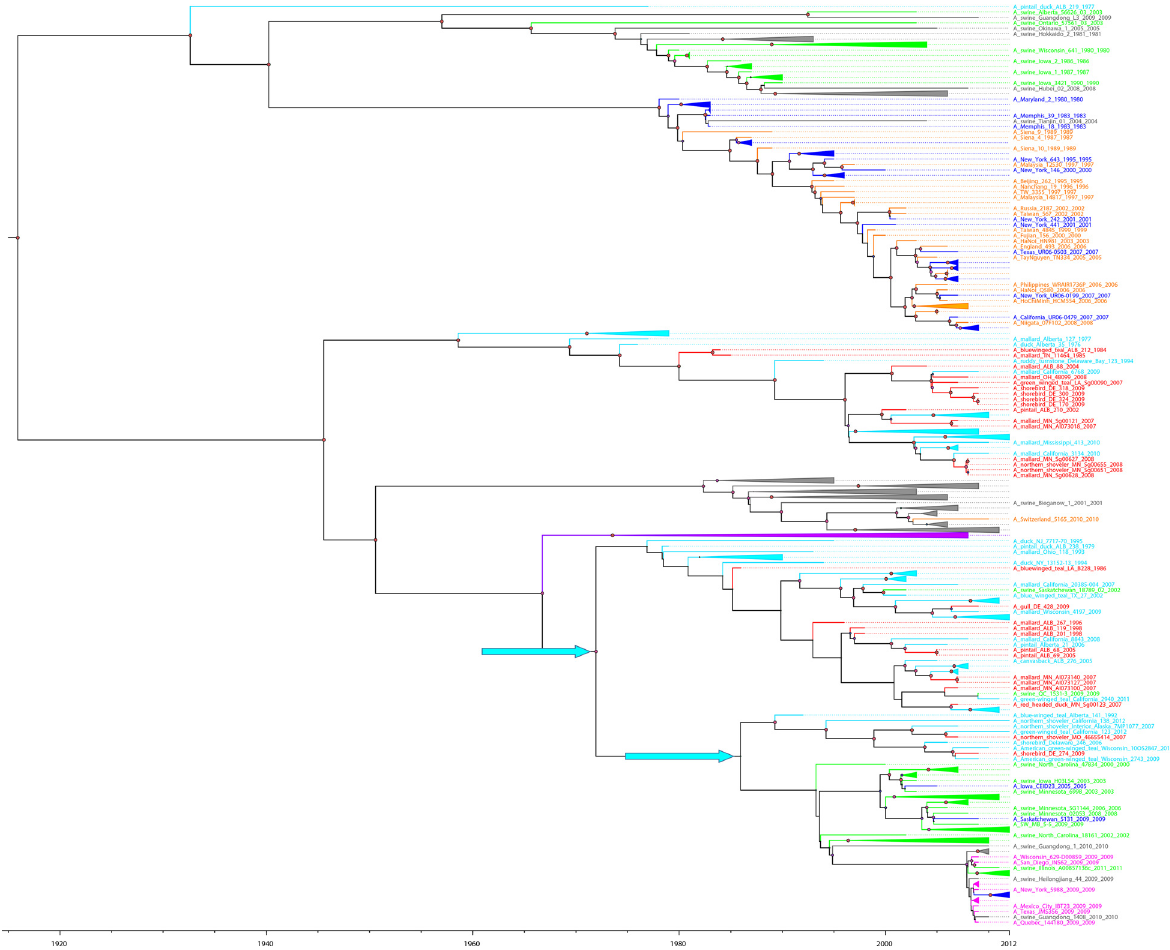
Fig 3. Evolutionary relatedness of PA gene segments of H1N1 IAVs of avian, swine and human origins isolated from North America and Eurasia. The taxa are colored based on their host and geography: red-North American avian isolates from the St. Jude repository, light blue-North American avian isolates, purple-Eurasian avian isolates, green- swine isolates from North America, grey- swine isolates from Eurasia (both Eurasian avian-like swine and Eurasian classical swine), dark blue-human isolates from North America; orange- human isolates from Eurasia, and pink- 2009 pandemic isolates. The nodes with spillover avian H1N1 IAVs are denoted with light blue